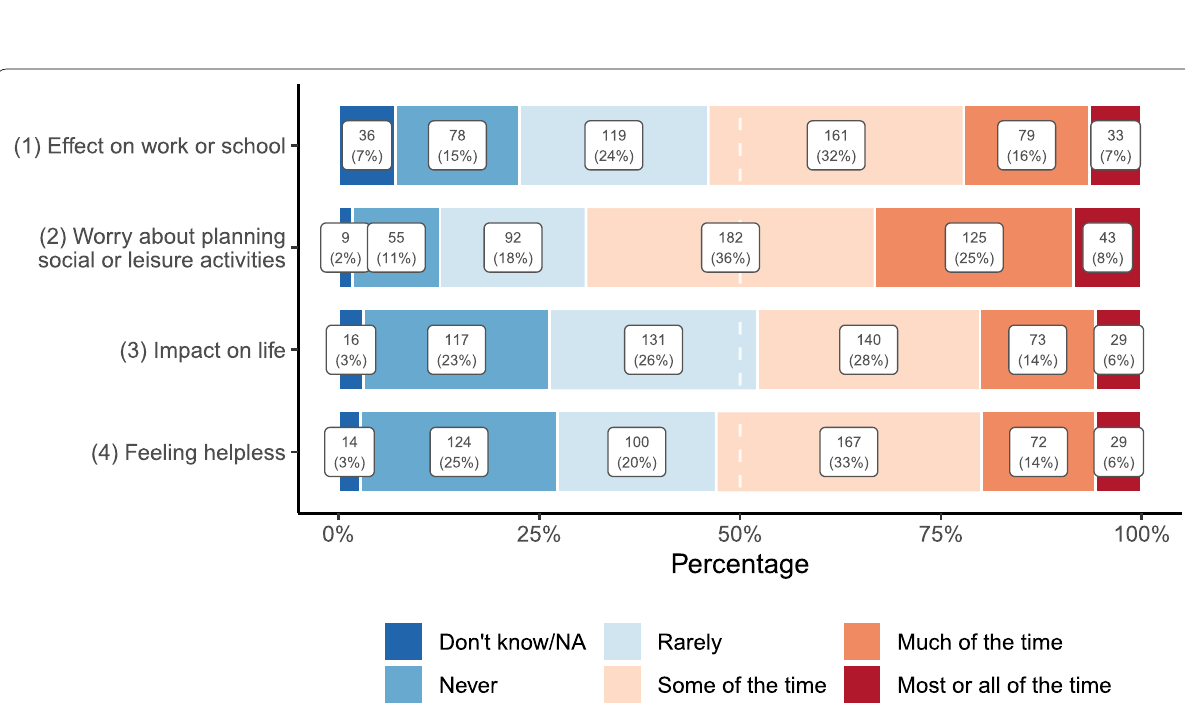
Fig. 2 Number (Percentage) of participants reporting MIBS-4 item-level